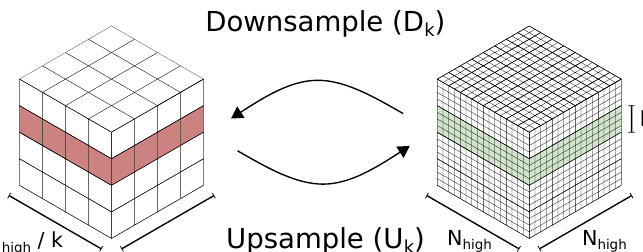
Figure 4. Two voxel grids at different resolution. The low-resolution grid on the left can be up-sampled ( U k ) to a high-resolution grid. This transforms a slice (in red, left) into a slab (in green, right), which consists of multiple slices. The down-sampling operation ( D k ) performs the reverse transformation. Here, the up-sampling and down-sampling are performed with magnification factor k = 4, which increases or decreases the number of voxels in each dimension by a factor of k .